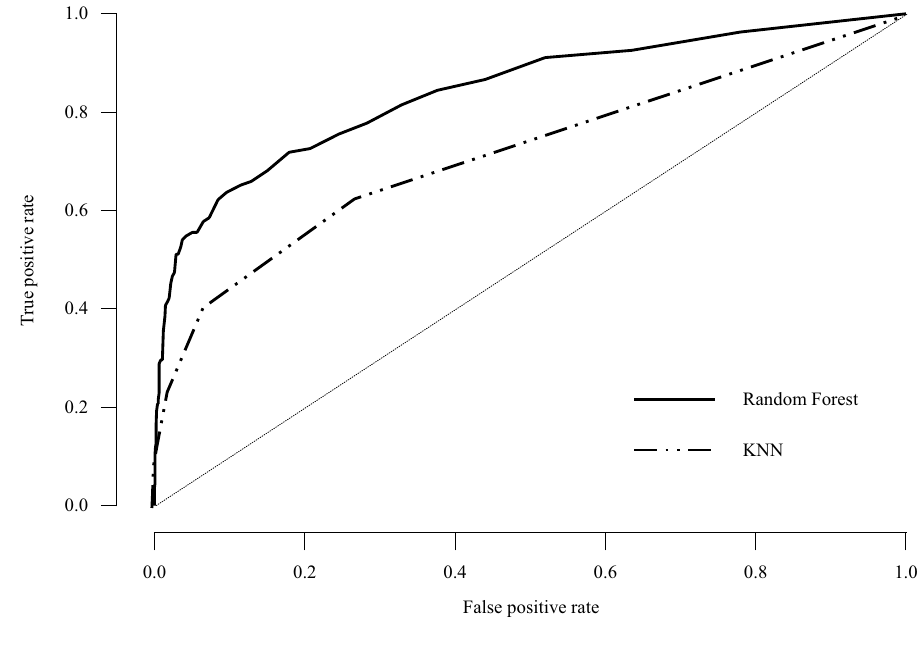
Figure 1. ROC curve plots for suicidal ideation.